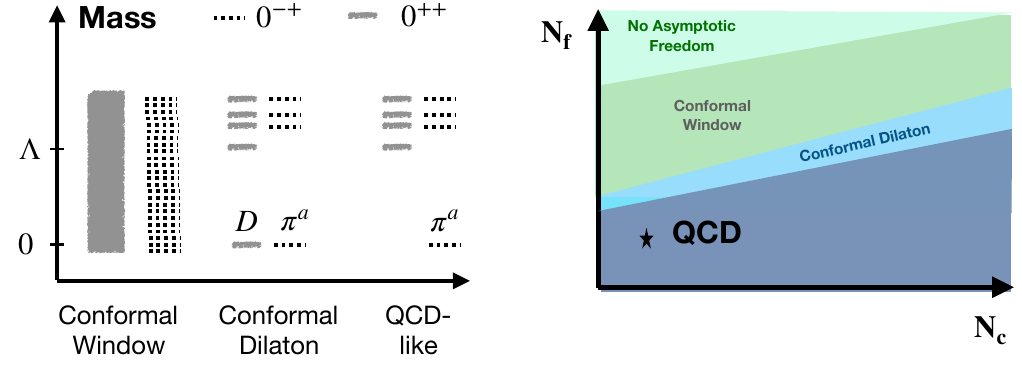
Figure 1 . (left) Schematic spectra of conformal window, conformal dilaton and a QCD like theory in the m 0 limit. (right) Qualitative phase diagram of a given matter representation as a function q → of the number of colours and flavours. The boundary of asymptotic freedom is well-established and known as the Banks-Zaks region. The boundary with the QCD region is a matter of debate. The light-blue conformal dilaton phase is the one discussed in this paper. We wish to emphasise that this is just schematic and that the region of this phase could be rather different (should it exist at all). In this paper we discuss its logical possibility and speculate in section 4.2 that QCD itself could be of this